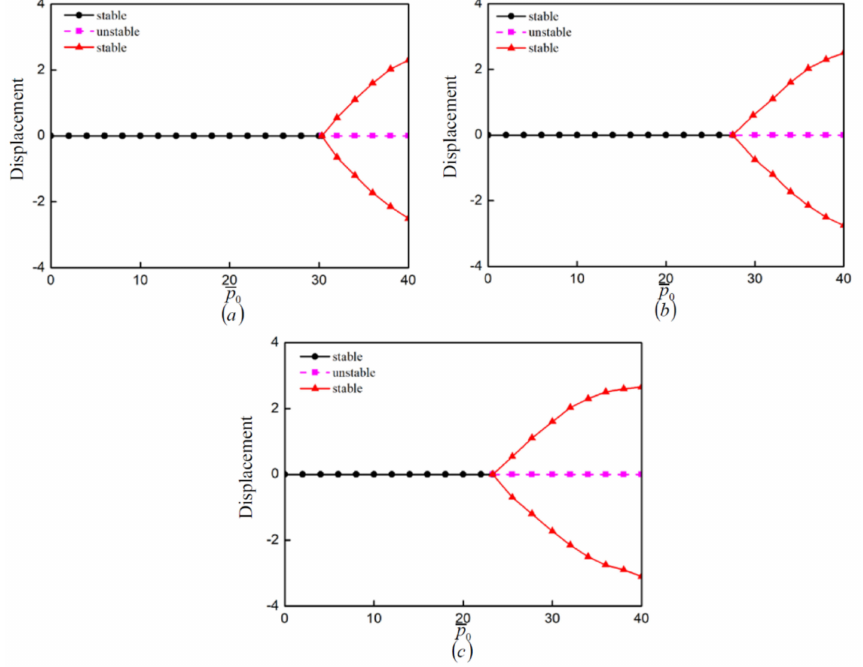
Figure 8. The transverse deflection of the CFRP laminated cylindrical shell versus the static in-plane load with different ratios of radius to thickness R / h : ( a ) R / h = 10, ( b ) R / h = 20, ( c ) R / h =